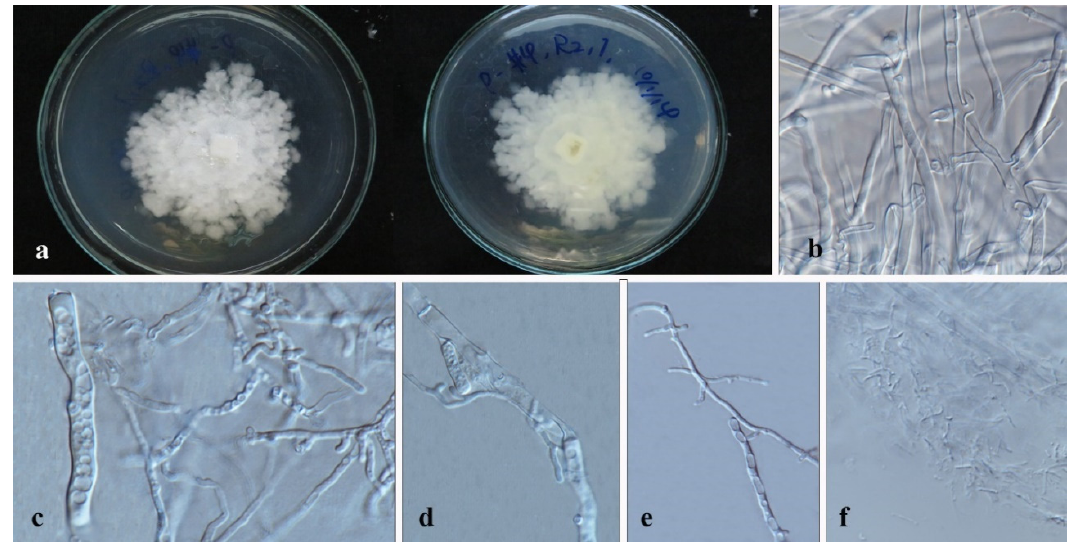
Figure 10. Hypoxylaceae sp. ( a ) Colony on PDA (MFLUCC 14-0141) (left-front view, right-reverse view). ( b , c ) Mycelia. ( d , e ) Conidiophore-like structures. ( f ) β conidia-like structures Notes: ( b – f ) on 4% OA.